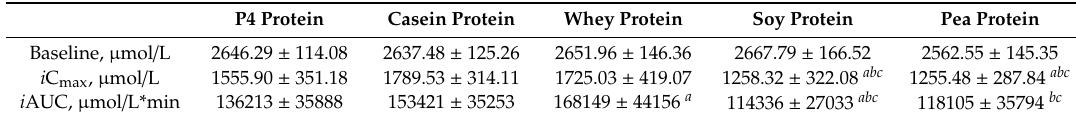
Figure 2. Post-prandial plasma TAA responses of the study products (mean ± SD). Table 3. Plasma concentrations of TAA.